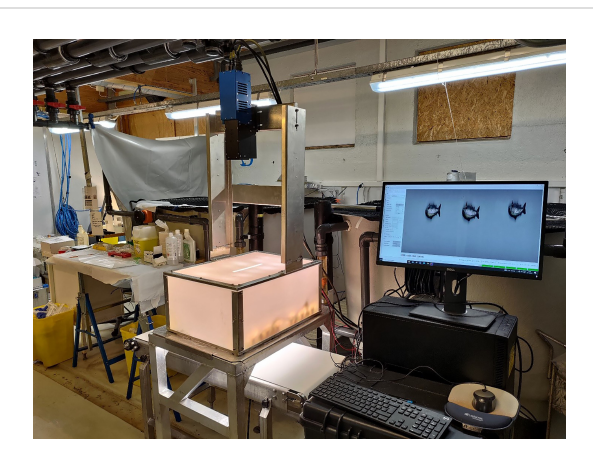
FIGURE 1 Imaging setup. A conveyor belt is illuminated by halogen light bulbs in an open-bottomed Te fl on box, which produces an even diffuse fi eld of light. A hyperspectral pushbroom camera is mounted above the Te fl on box and scans the conveyor belt through a slit in the top of the box. The camera is operated by a computer alongside the conveyor